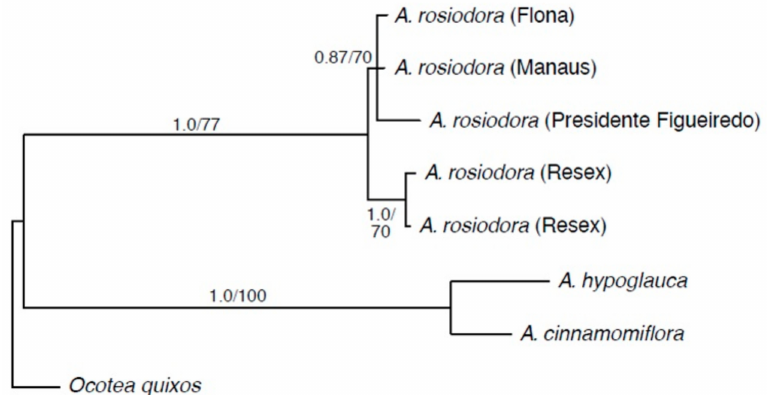
Figure 6. The 50% majority rule tree from Bayesian analysis of a concatenated dataset of plastid psbA – trhH , psbD – trnT , trnC – rpoB , and trnS – trnG . Branch support values are Bayesian posterior probabilities ≥ 0.5/maximum parsimony bootstrap ≥ 50%. The dashed line indicates a branch that was present